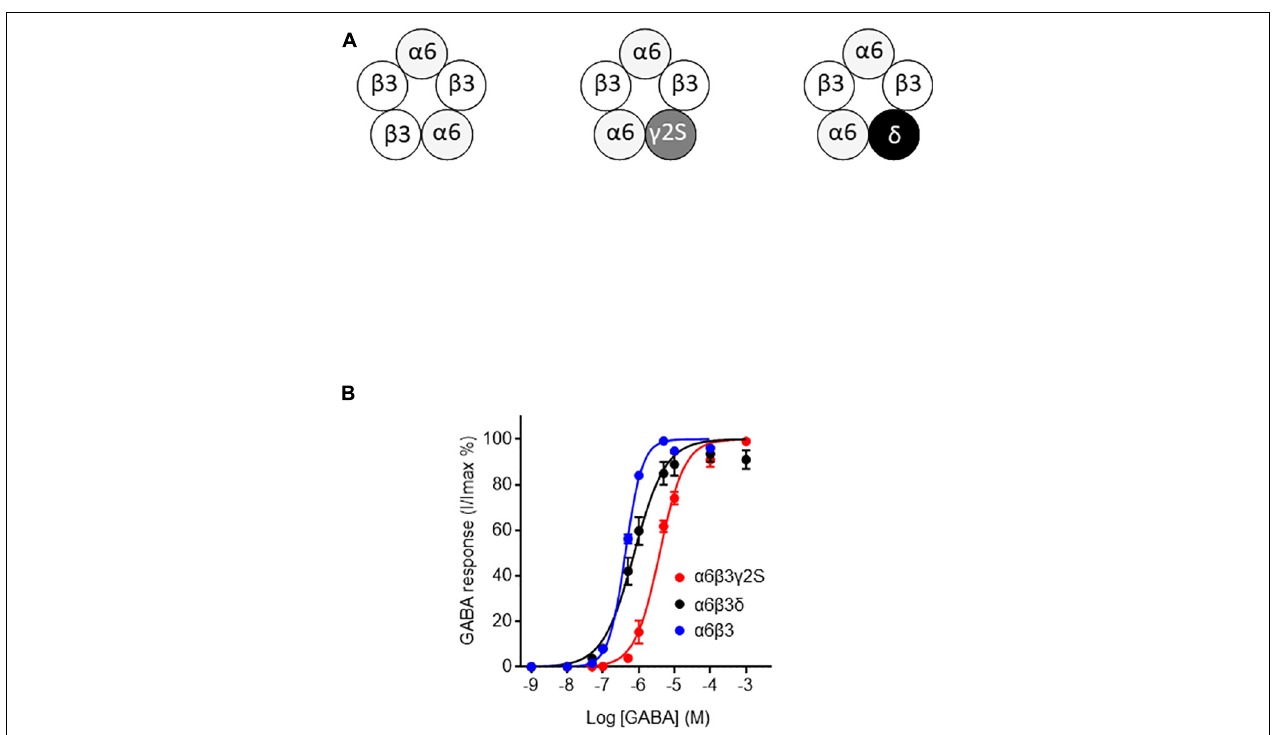
FIGURE 2 | GABA sensitivity of ternary and binary α 6-containing GABA A Rs. (A) Stoichiometric organization of α 6-containing GABA A Rs used in this work (see Baumann et al., 2001; Baur et al., 2010; Sigel and Steinmann, 2012). (B) Concentration-response curves for α 6 β 3 γ 2S, α 6 β 3 δ , and α 6 β 3 GABA A Rs. Data were best fitted by non-linear regression to the Hill equation with variable slope α 6 β 3 γ 2S: EC 50 = 3.85 ± 0.28 µ M and Hill-coefficient = 1.24 ± 0.08, R 2 = 0.98; α 6 β 3 δ : EC 50 = 0.75 ± 0.09 µ M and Hill-coefficient = 0.99 ± 0.09, R 2 = 0.95; α 6 β 3: EC 50 = 0.43 ± 0.01 µ M and Hill-coefficient = 1.83 ± 0.09, R 2 = 0.99). Data are mean ± SEM ( n = 4–8) of at least two independent